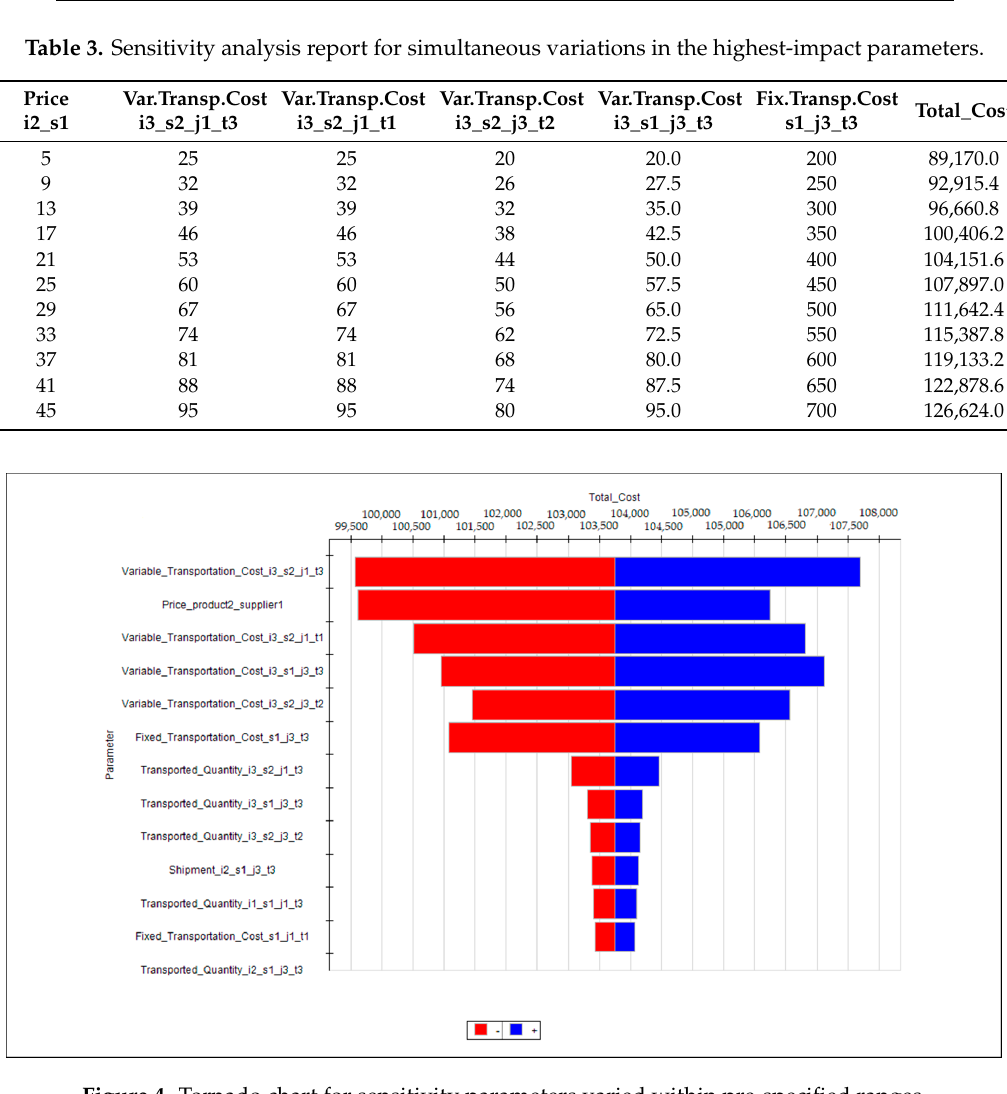
Figure 4. Tornado chart for sensitivity parameters varied within pre-specified